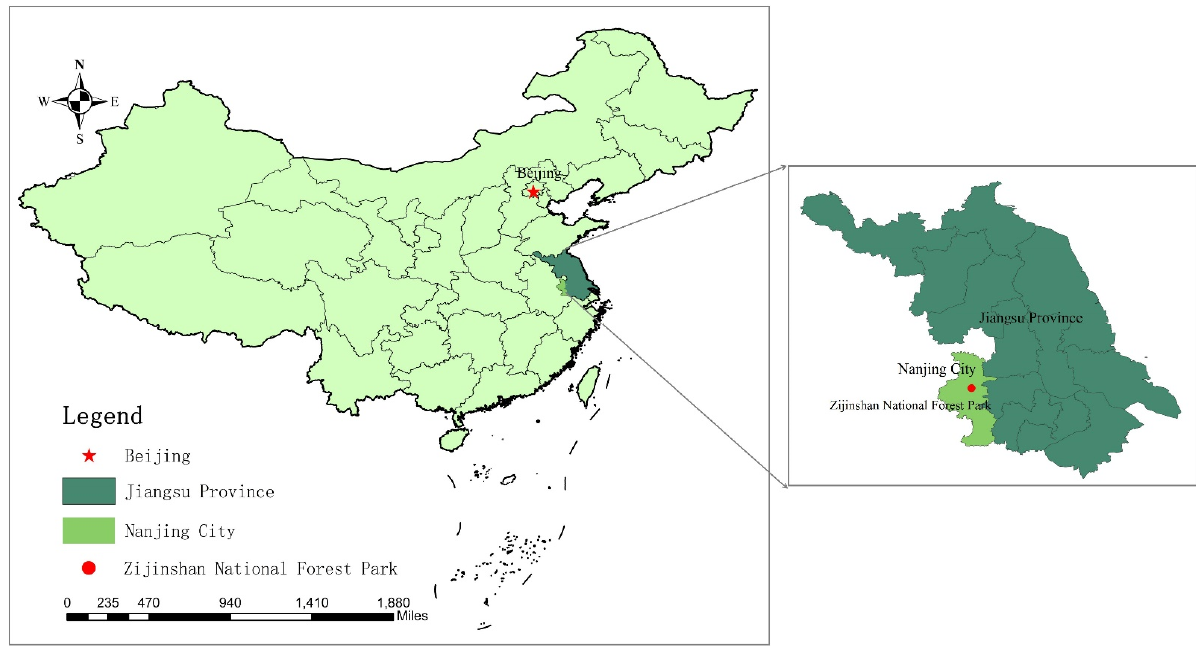
Figure 2. Location of Zijinshan National Forest Park in Jiangsu Province, China.